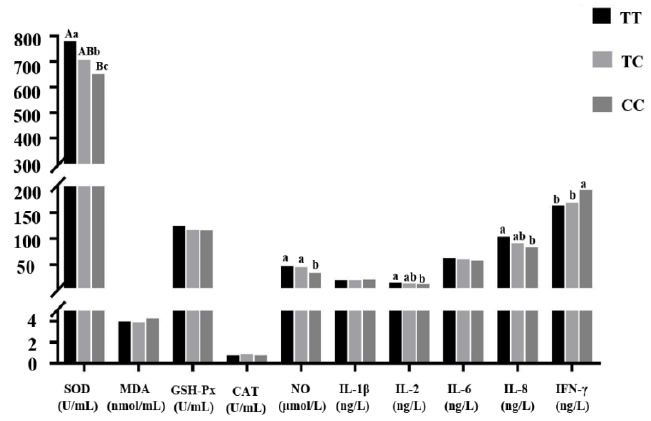
Figure 5. Correlation analysis between each genotype of the IL-8 gene T–360C mutation and coccidiosis resistance indexes.